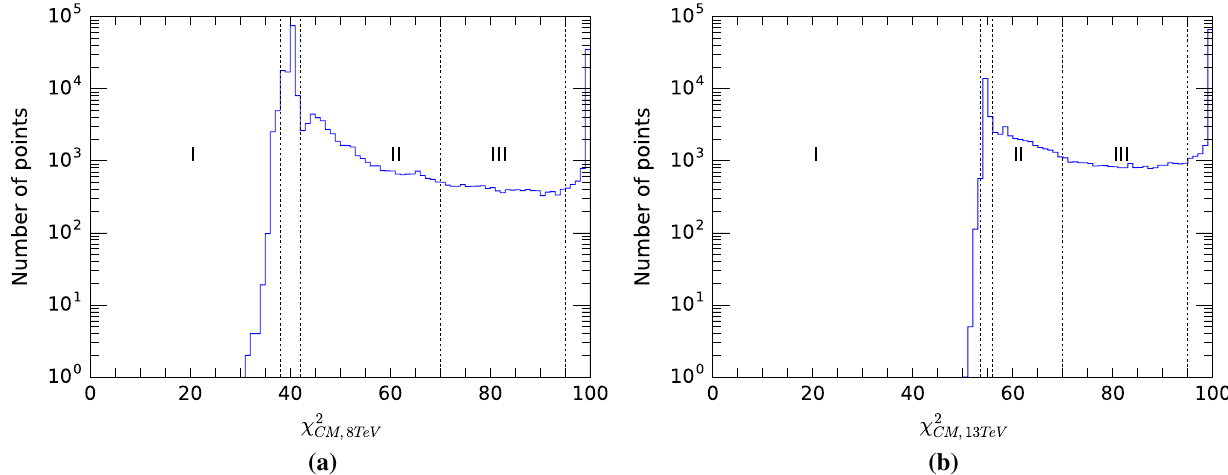
Fig. 4 Distributions of χ 2 for 8 TeV ( a ) and 13 TeV ( b ). The dashed lines indicate ranges for which we evaluated the performance of the CM